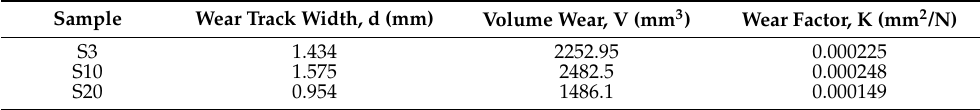
Table 2. Wear track width measured from optical microscopy and volume wear and wear factor calculated using Equations (2) and